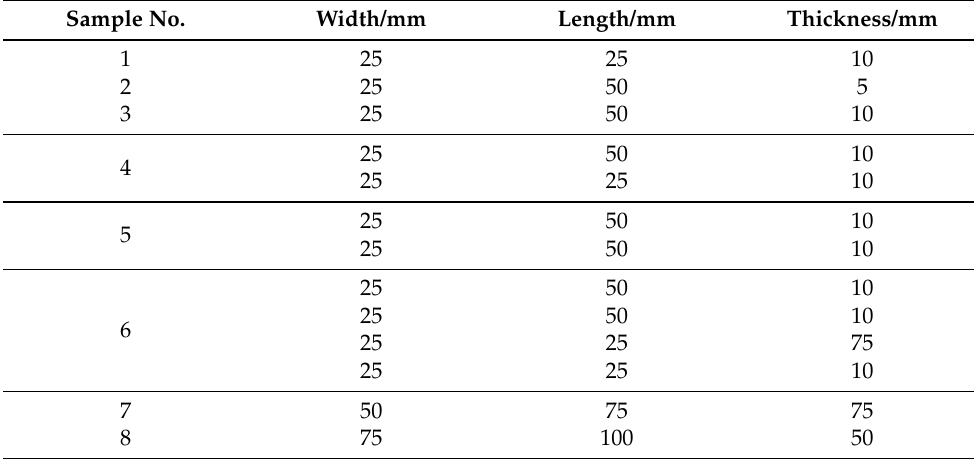
Figure 2. Concrete sample and test procedure. Table 1. Size of subsurface